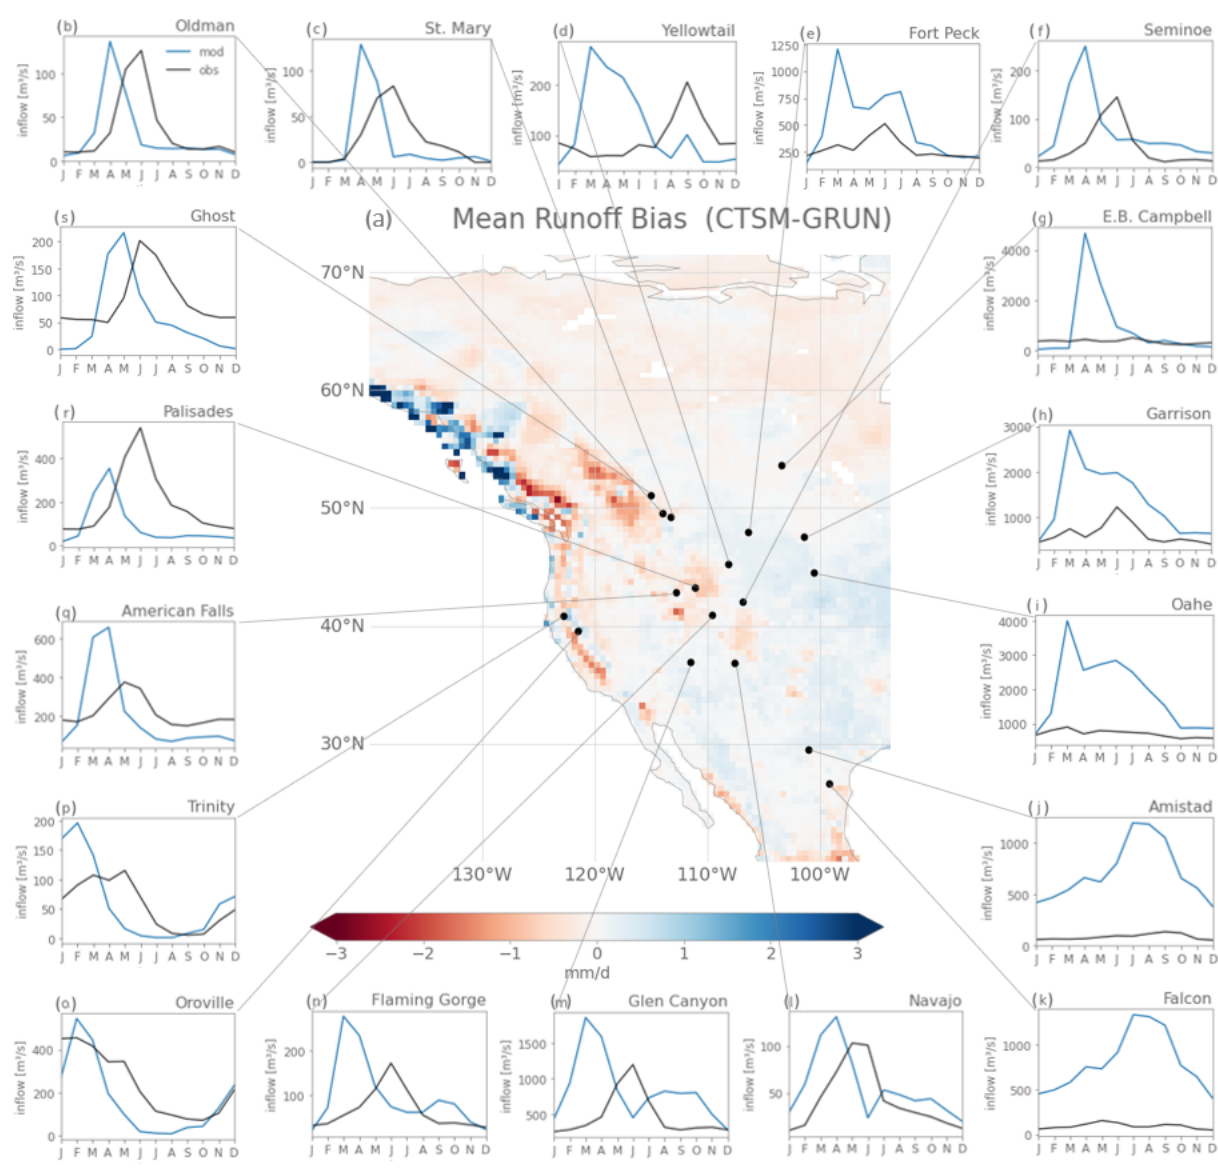
Figure 7. Mean runoff bias of CLM compared to G-RUN for CONUS and Canada with location of reservoirs (a) . Simulated (blue line) and observed inflow (black line) seasonality per reservoir (b–s)